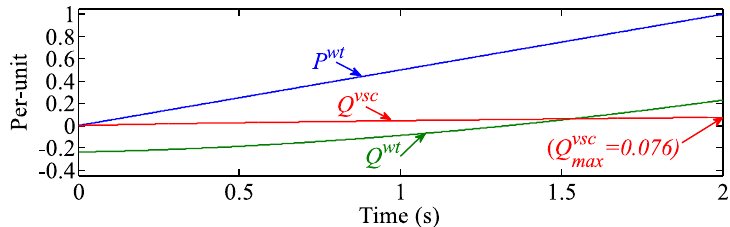
Figure 7. WT active power and dynamic responses of the WT and the VSC reactive powers in the VSC power rating